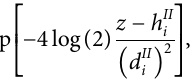
Frontiers in Earth Science |